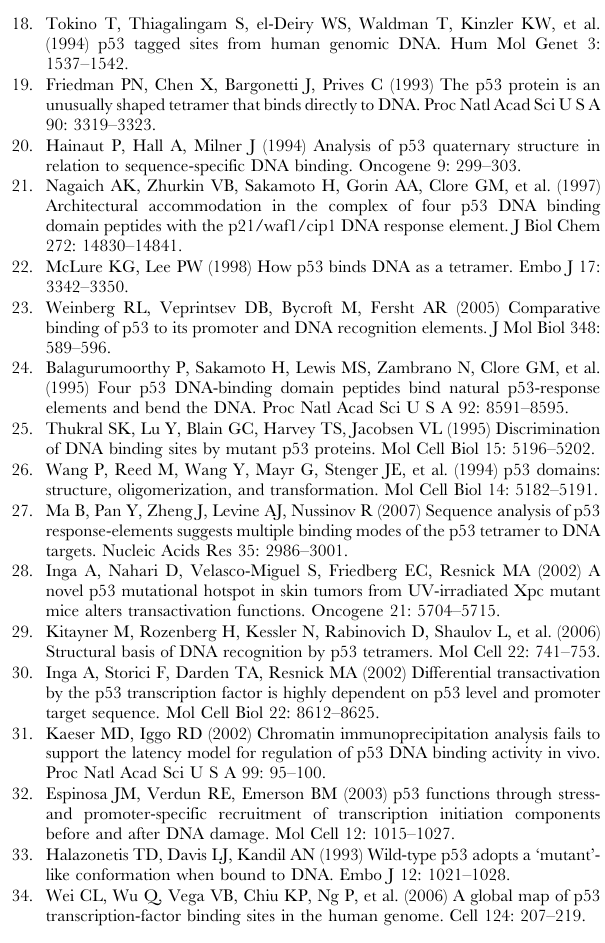
Figure S4 Mutant p53 expression. To exclude the possibility